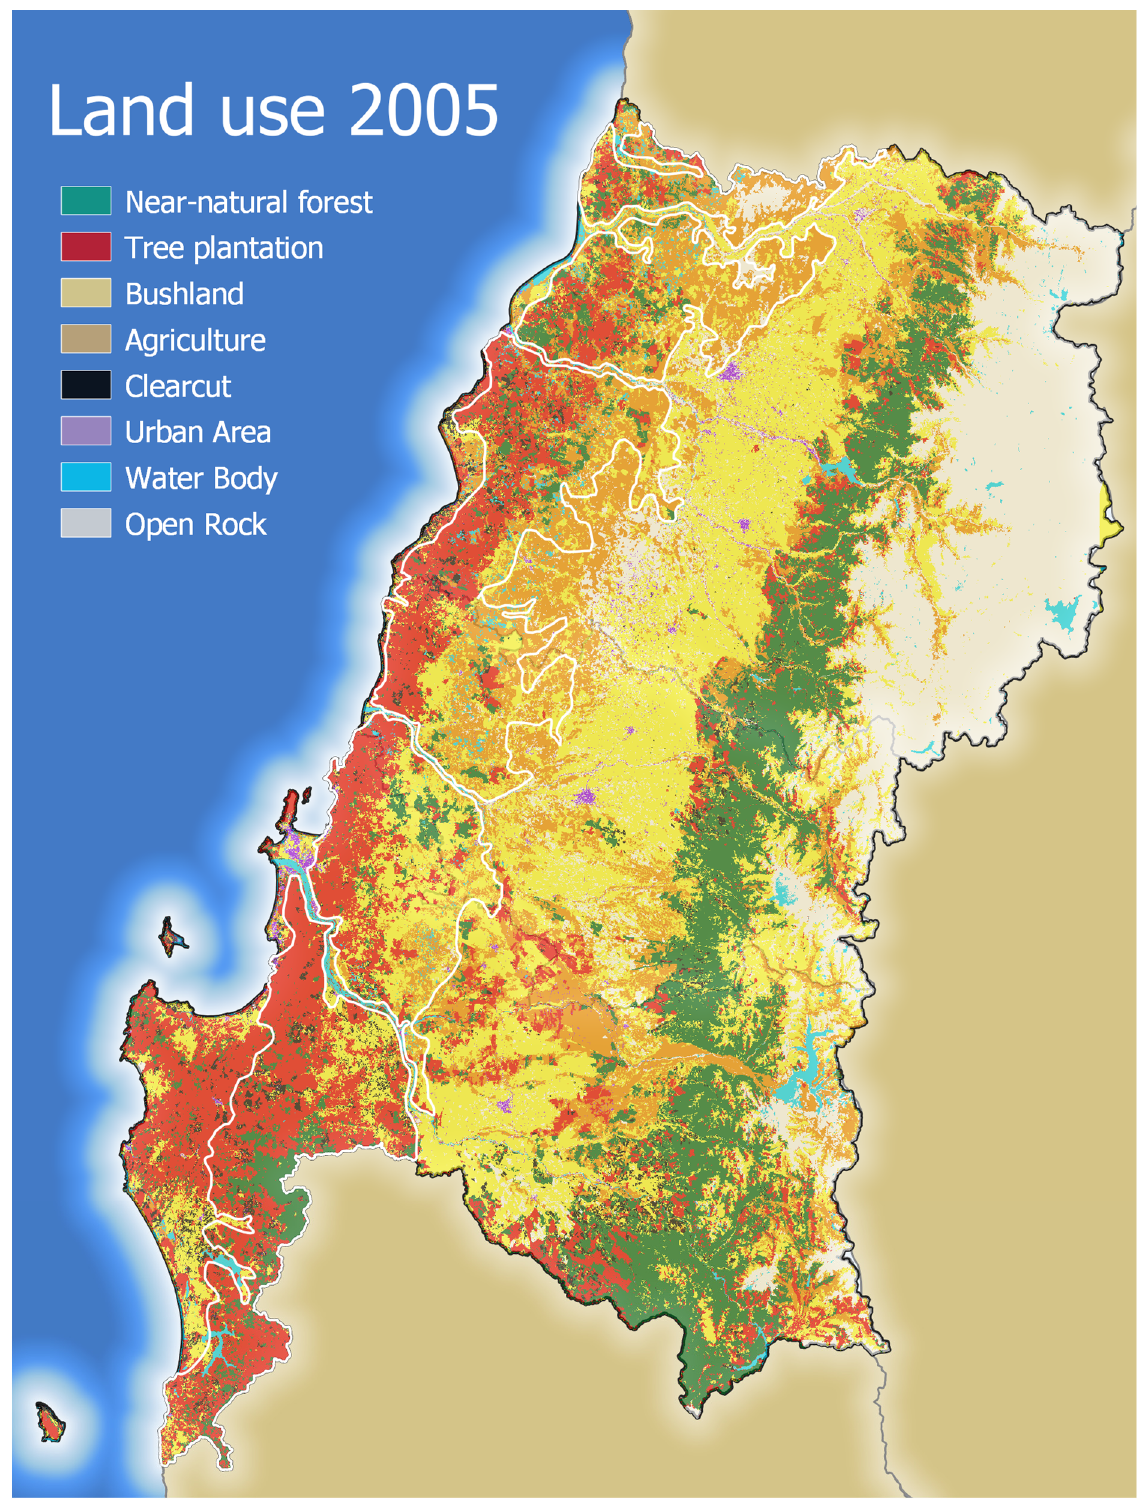
Figure A7. Land use map of study site in 2005.